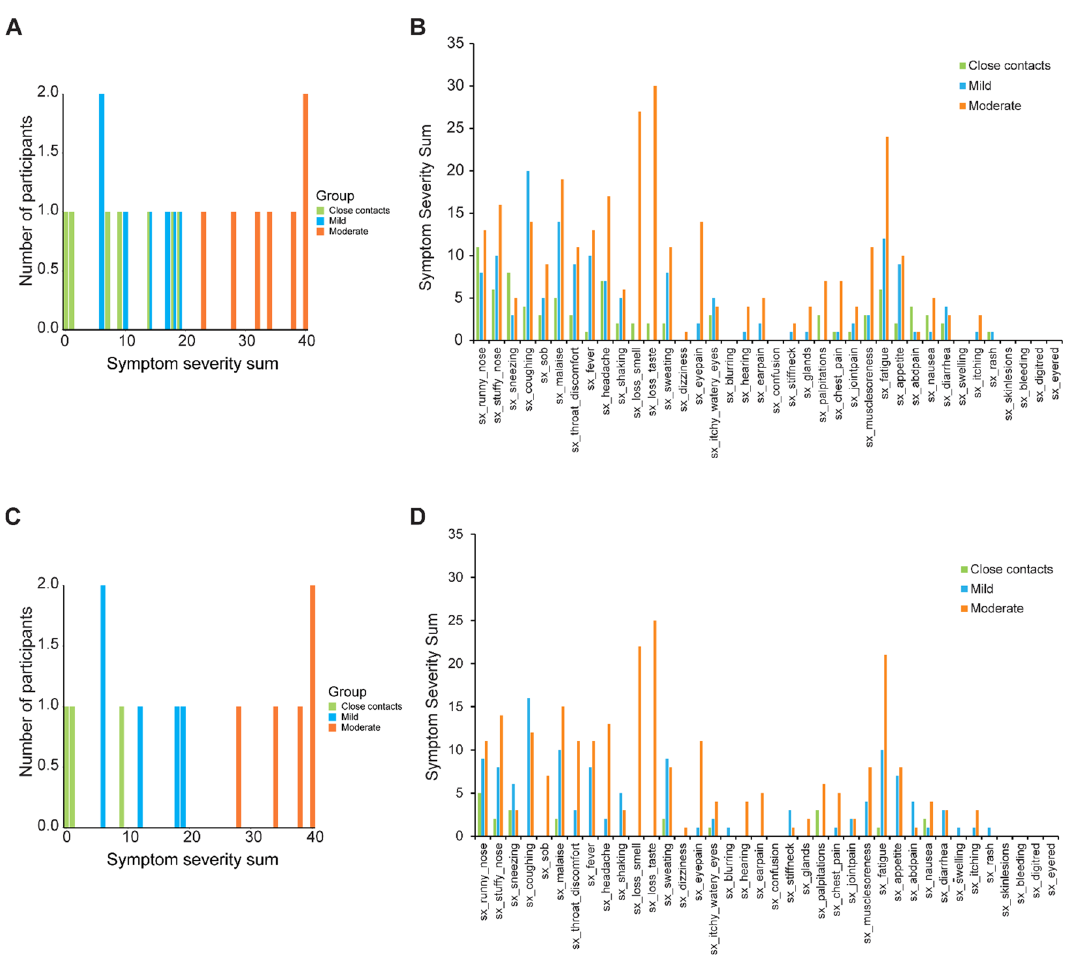
Figure 1. ( A ) Symptom severity sums for the subjects profiled with bulk assays and ( B ) severity scores for each reported symptom for the subjects profiled with bulk assays. ( C ) Symptom severity sums for subjects profiled with single-cell assays and ( D ) severity scores for each reported symptom for the subjects profiled with single- cell assays. For both cohorts, the sum of severity scores for all reported symptoms are shown for close contacts (green), COVID-19 subjects with mild symptoms (blue), and with moderate symptoms